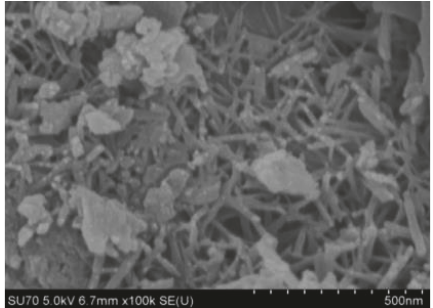
Figure 7: SEM of cement paste without NO 2 - .